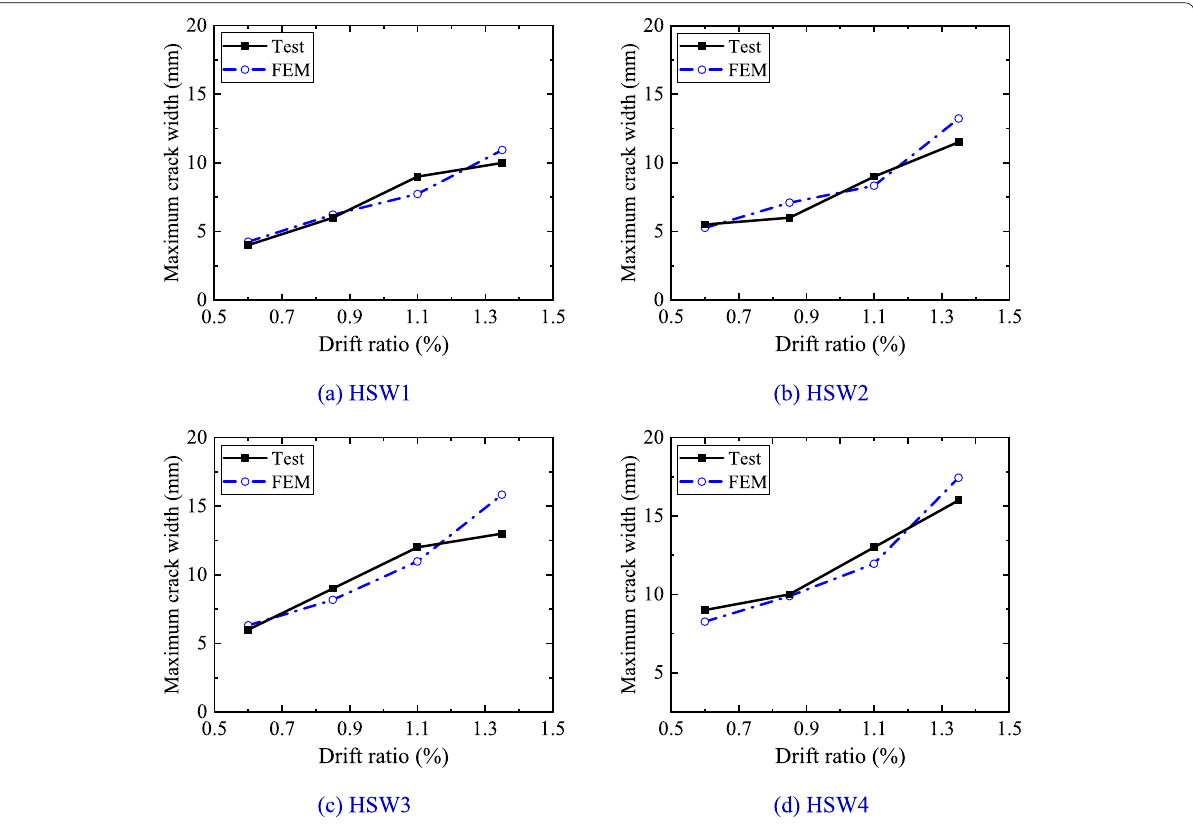
Fig. 7 Comparison of maximum crack width for all test